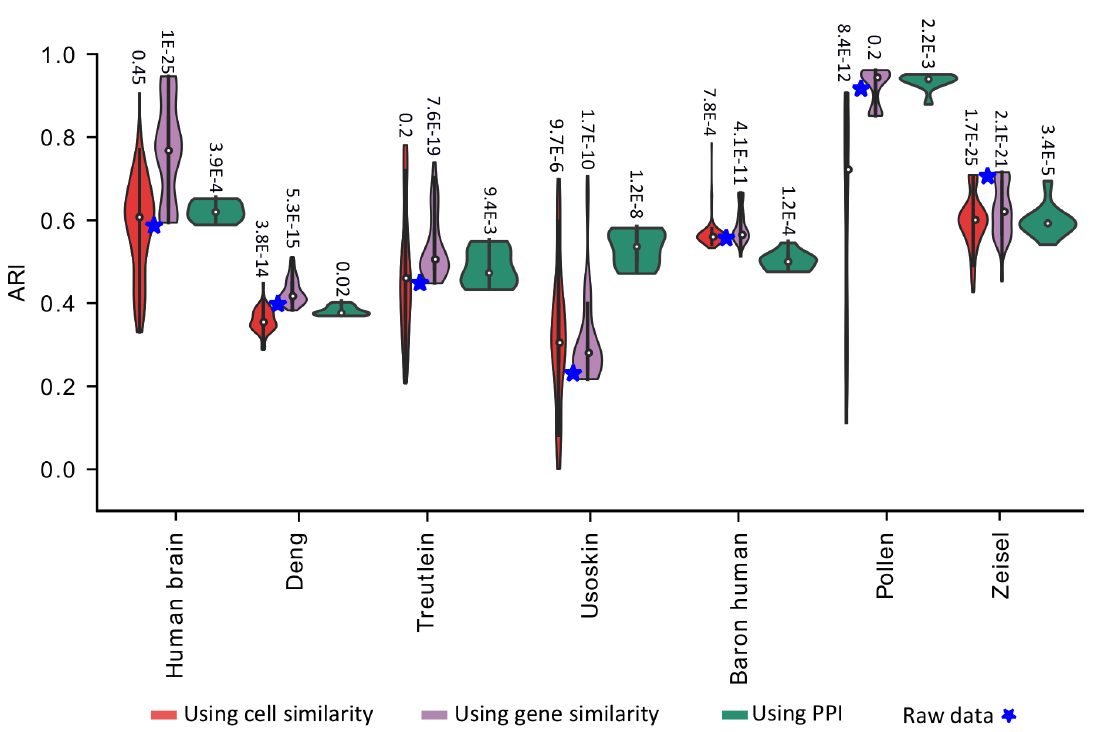
Figure 2. The netImpute utilizing information from gene similarity significantly enhances the clustering accuracy of real datasets.Violin plot showing the ARI obtained by netImpute-treated data based on cell similarity and gene similarity for different parameter settings ( α and k ) and based on the protein–protein interaction (PPI) network for different values of α . Values on top of the violin plots show the p -value obtained from t -test comparing the adjusted rand indices (ARIs) from imputed data with ARI from raw